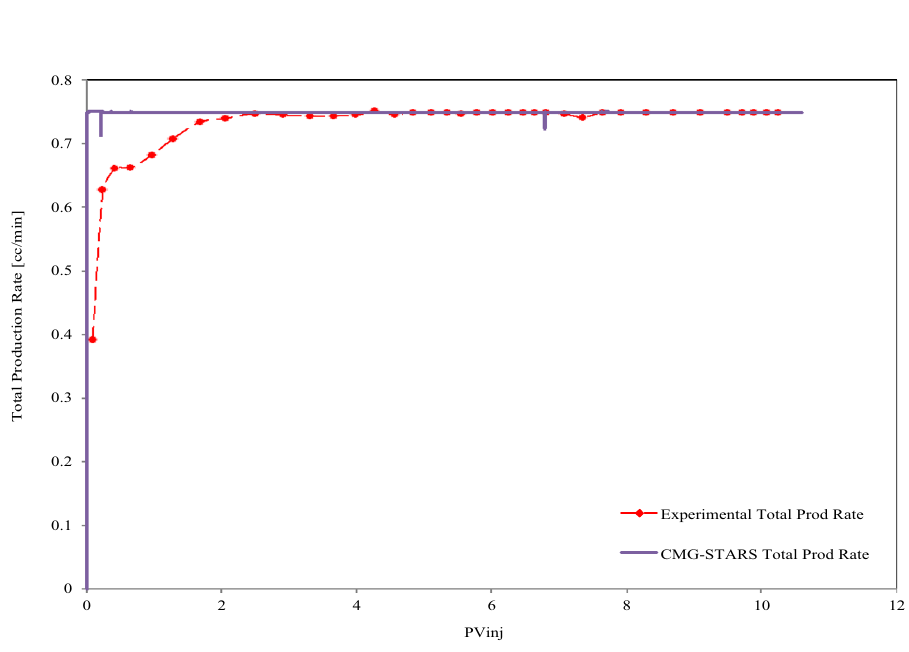
The cumulative oil production at the end of the first step (waterflooding) for experimental and STARS results are 45.83 and 46.00 [% OOIP], respectively. After chemical flooding and the chase water of both the experimental